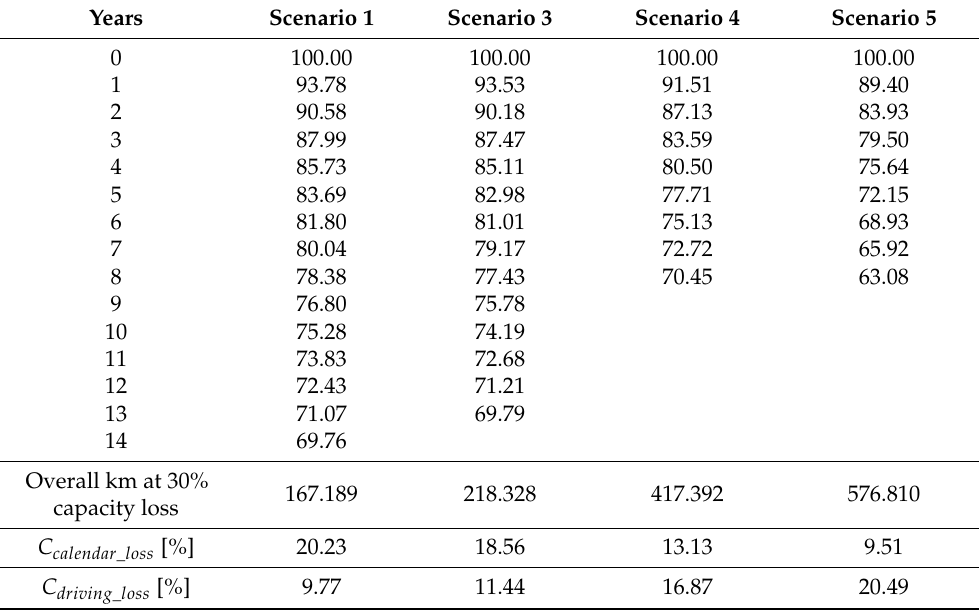
Table 15. Estimated capacity loss percentage in the vehicle according to the scenarios @ 15 ◦